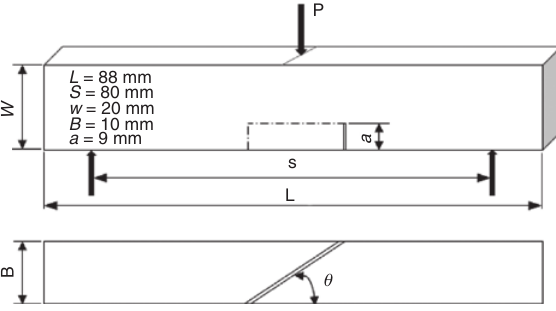
Figure 1: Schematics of the geometrical configuration SENB specimen.